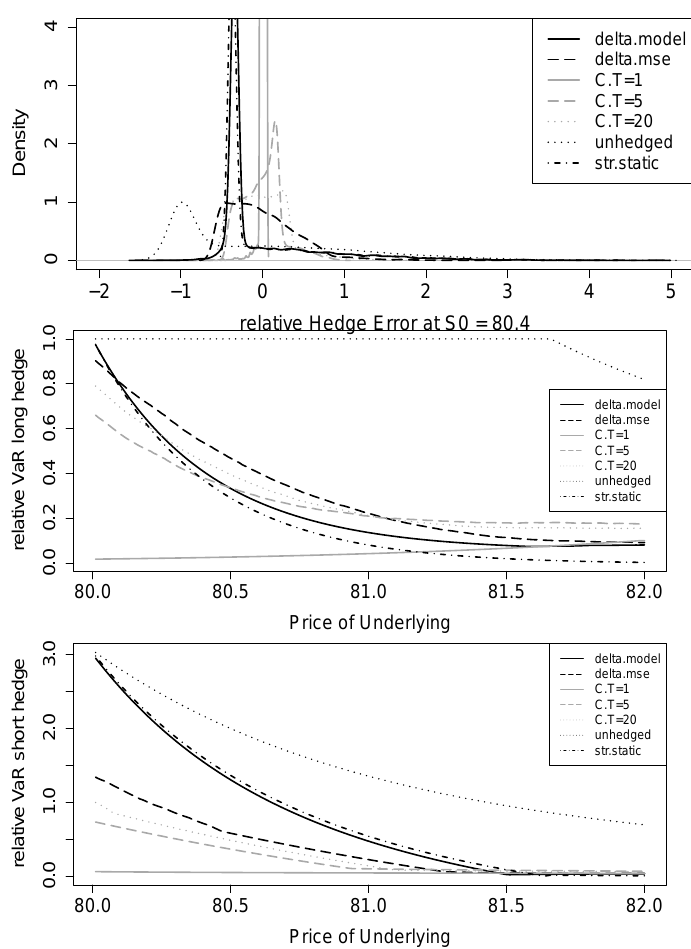
Figure 6. Black–Scholes model with overnight trading gap: hedge error densities and value-at- risk for long and short hedges. The densities are calculated for an underlying price 0.5% above the barrier. Relative VaR figures refer to the 95% confidence level. Hedging object is a down-and-out put with K = 100, B = 80, and T = 20 days; the hedging period is ∆ t = 1 day. The hedging strategies are standard Black–Scholes delta (delta.model), MSE delta using the underlying (delta.mse), MSE delta using vanilla calls with time to maturity of 1 (C.T = 1), 5 (C.T = 5), and 20 (C.T = 20) days, strike-spread static hedging (str.static), and no hedging (unhedged). Relative VaR for a long hedge is bounded above by 100% (for the no-hedging